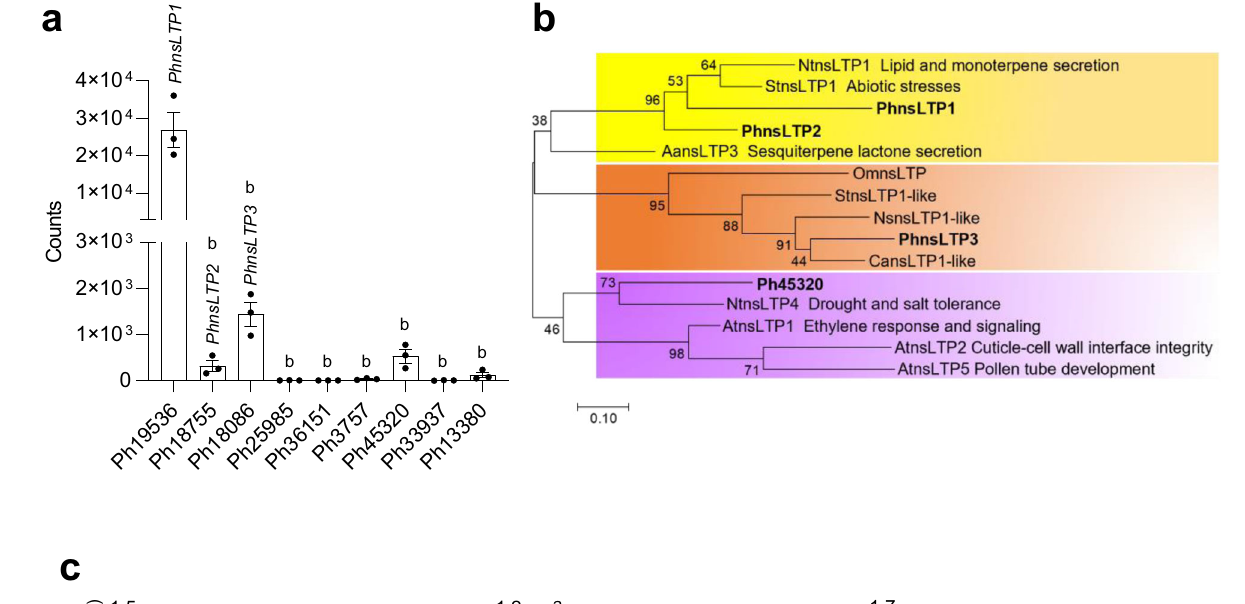
Fig. 1 | Expression analysis of petunia nsLTP candidates and phylogenetic analysisofPhnsLTP1,PhnsLTP2,PhnsLTP3,andPh45320intypeIplantnsLTPs subfamily.a Expressionofnine PhnsLTP candidatesinpetunia fl owersat20:00hon day 2 postanthesis. Gene expression was measured based on analysis of RNA-seq datasets 19 andrepresentsanaverageofcountsfromthreebiologicalreplicates±S.E. b Thephylogenetictreewasbuiltbythemaximum-likelihoodmethodintheMEGA7 package from the alignment of mature proteins using MUSCLE algorithm. At, Ara- bidopsis thaliana ; Nt, Nicotiana tabacum ; Aa, Artemisia annua ; St, Solanum tuber- osum ;Ns, Nicotianasylvestris ;Ca, Capsicum annuum ;and Om, Oryza meyerianavar. granulate . The scale bar indicates 0.1 amino acid substitutions per site. The per- centage of replicate trees in which the associated taxa clustered together in the bootstrap test (1000 replicates) are shown next to the branches. c Developmental expression pro fi les of PhnsLTP1 , PhnsLTP2 , and PhnsLTP3 in petunia corollas from